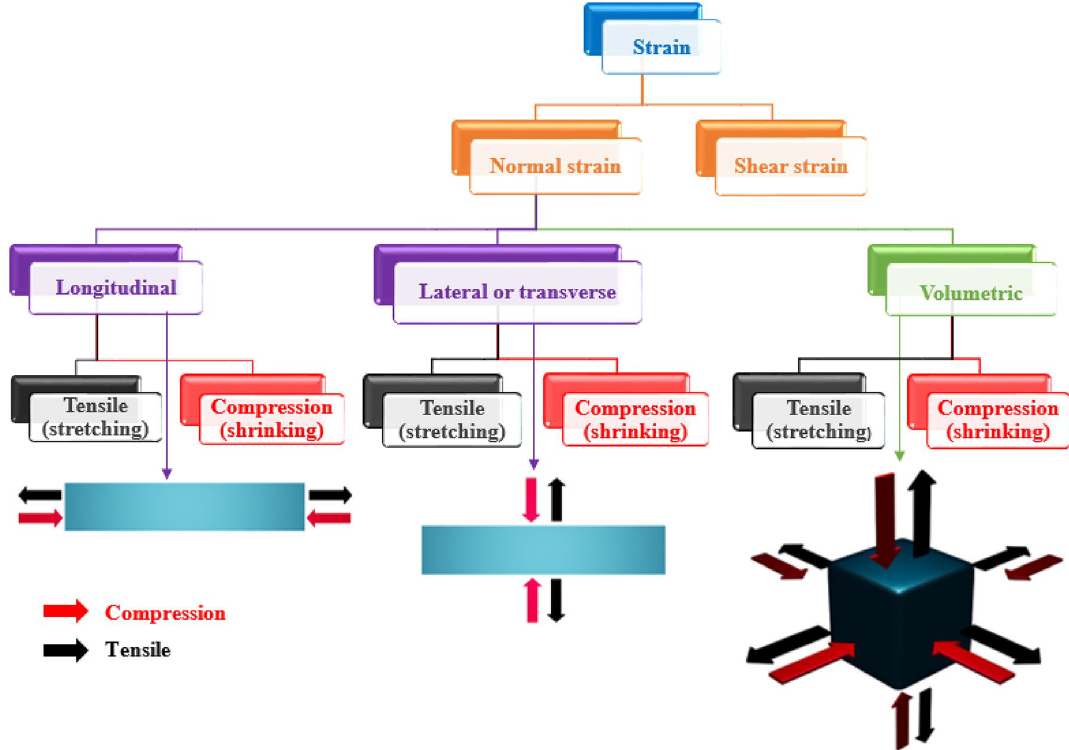
Figure 2. Classification of different externally inducible strains and their schematics. Overall, the externally inducible strain is classified into two types, in which we concern on inducing different normal strains. This normal strain is classified into three types: longitudinal (applying strain in horizontal direction w.r.t the material), lateral (applying strain in vertical direction w.r.t the material) and volumetric (applying strain through all the sides) and best examples of volumetric strain is biaxial strain. The schematic representation of three different normal strain inducements were shown below. In all the three different normal strains, there are only two possible ways of creating strain effects, that is creating either tensile or compression effects. Tensile effect creates stretching of material and compression creates shrinking of material. For example: longitudinal tensile strain is stretching the material towards horizontal direction and longitudinal compressive strain is shrinking of material in horizontal direction and as similarly lateral and volumetric tensile and compressive strain effects behaves.